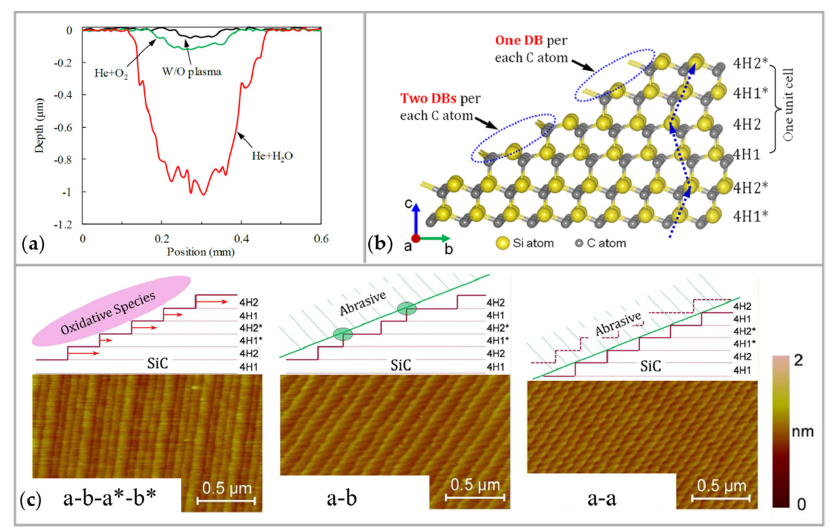
Figure 12. The influence of parameters on polishing results in PAP: ( a ) Comparison of removal depth when using O 2 and H 2 O as precursor gas after ball-on-disc test [94]; ( b ) The crystal structure of 4H-SiC [101].; ( c ) Generation mechanism and AFM images of surfaces step–terrace structure of polished SiC (a-b-a*-b* type: step-terrace structure with a narrow terrace, a wide terrace and two terraces of intermediate width; a-b type: step-terrace structure with alternating narrow and wide terrace pairs; a-a type: step-terrace structure with a uniform terrace width) [101]. 2.2.3. Combination with Other Polishing Approaches To extend the plasma polishing application to materials with poor machinability such as CVD-SiC and GaN, the PAP and plasma treatment were combined with other polishing approaches. A dry plasma etching process can efficiently remove the sub-surface damage and scratches formed by previous mechanical processes, but the surface roughness after dry plasma etching typically increases. PAP using resin-bonded grinding stones can decrease the roughness from 2.93 to 0.69 nm in RMS without causing sub-surface damage and scratches. The combination of the dry plasma etching process and PAP can realize the damage-free finishing of CVD-SiC substrates, as shown in Figure 13a [102]. Plasma pretreatment was also used to modify the surface of GaN [103]. The modified layer inhibits the formation of etch pits on the workpiece, which is a tricky issue in pol- ishing GaN and the cause of high roughness. As depicted in Figure 13b, time-controlled CMP followed by plasma pretreatment could provide damage-free finishing and rough- ness of 0.11 nm in RMS.